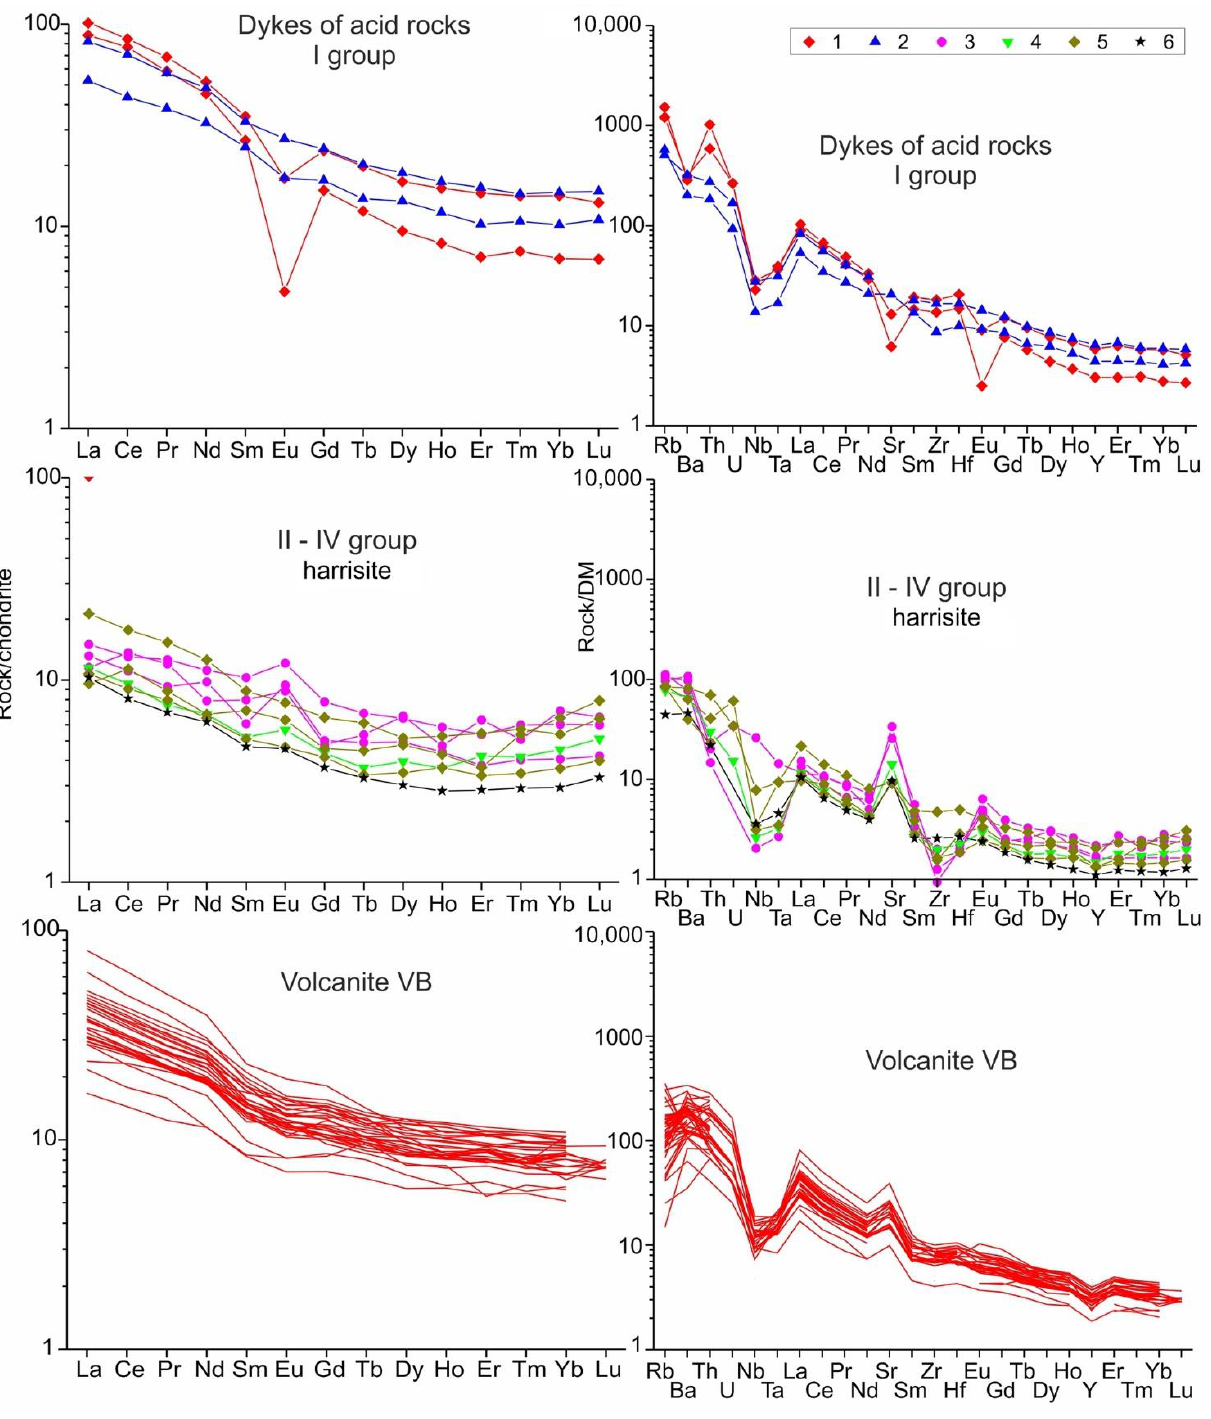
Figure 17. REE distribution, normalized to chondrite [33], and spider-diagram, normalized to DM [32], in rocks of the dyke complex and komatiitic basalts from the Vetreny Belt. For the description, see Figure 16.